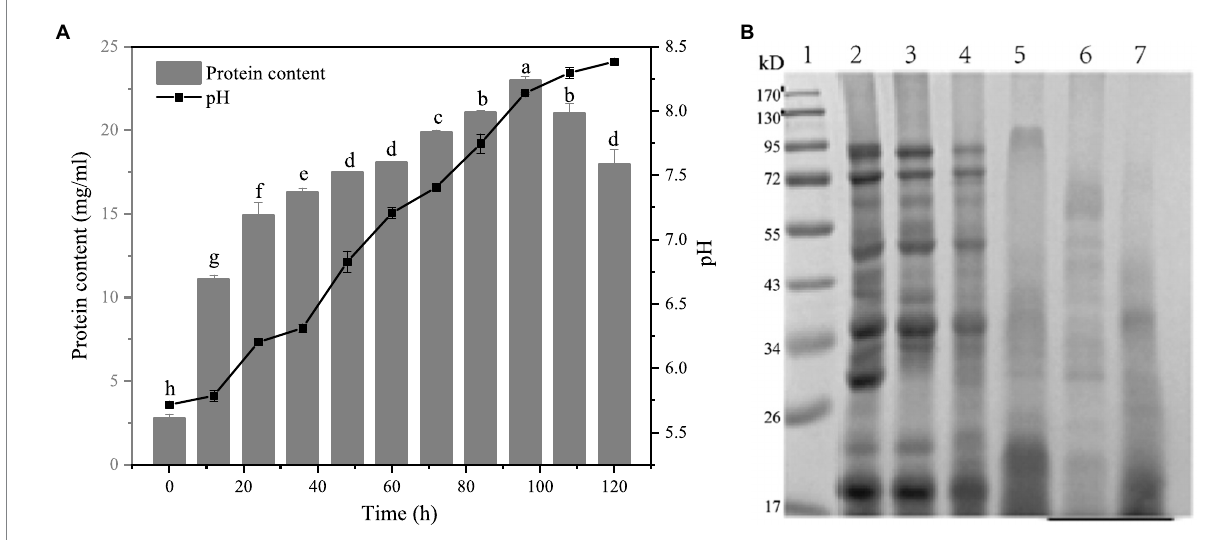
FIGURE 3 Changes of pH, soluble protein content and SDS-PAGE electrophoretic pattern of gluten of fermentation broth at different fermentation times. (A) Changes of pH, soluble protein content of fermentation broth at different fermentation times. (B) Changes of SDS-PAGE electrophoretic pattern of gluten in different fermentation stages of Bacillus subtilis fermentation. Lane 1: Marker, lane 2: unfermented gluten, lane 3–7 are gluten fermented for 0, 12, 24, 36, and 48